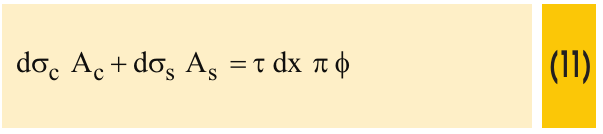
Figure 12 – Steel-concrete bonding